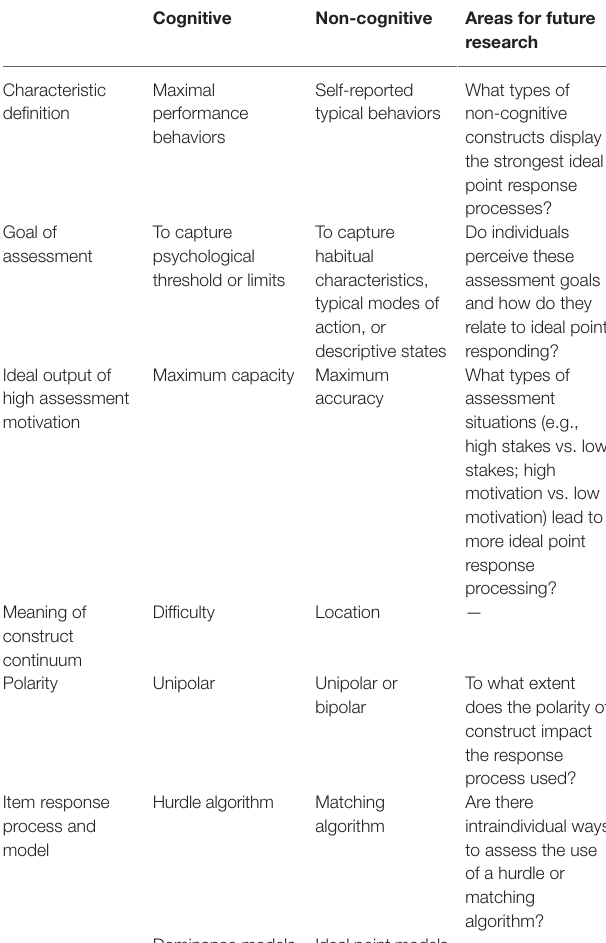
TABLE 1 | Key distinctions between cognitive and non-cognitive